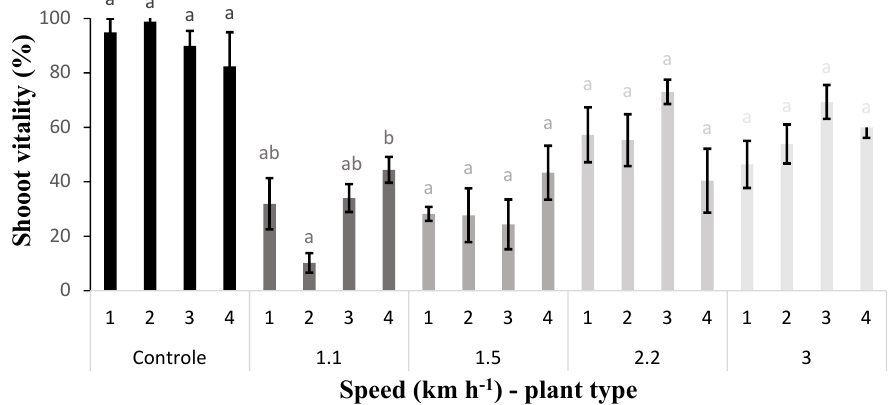
Figure 5. Shoot vitality (%) of electrocuted C. esculentus plants for each combination of speed (km · h − 1 ) and plant type in the Zasso experiment at Bocholt in 2021. Means sharing the same letter are not significantly different ( p < 0.05); comparison within speed